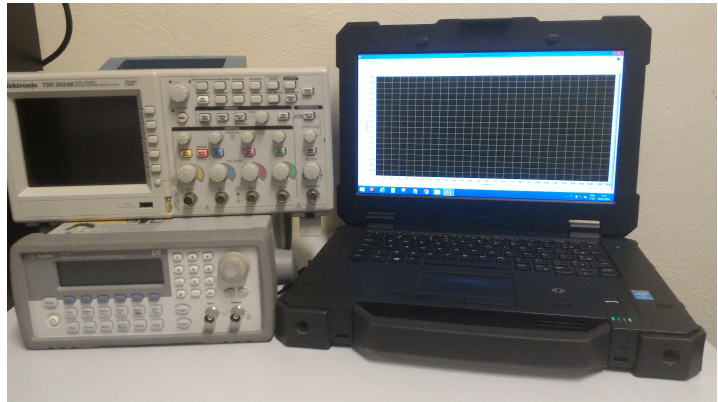
Figure 11. Implemented system for identification and location of track circuit